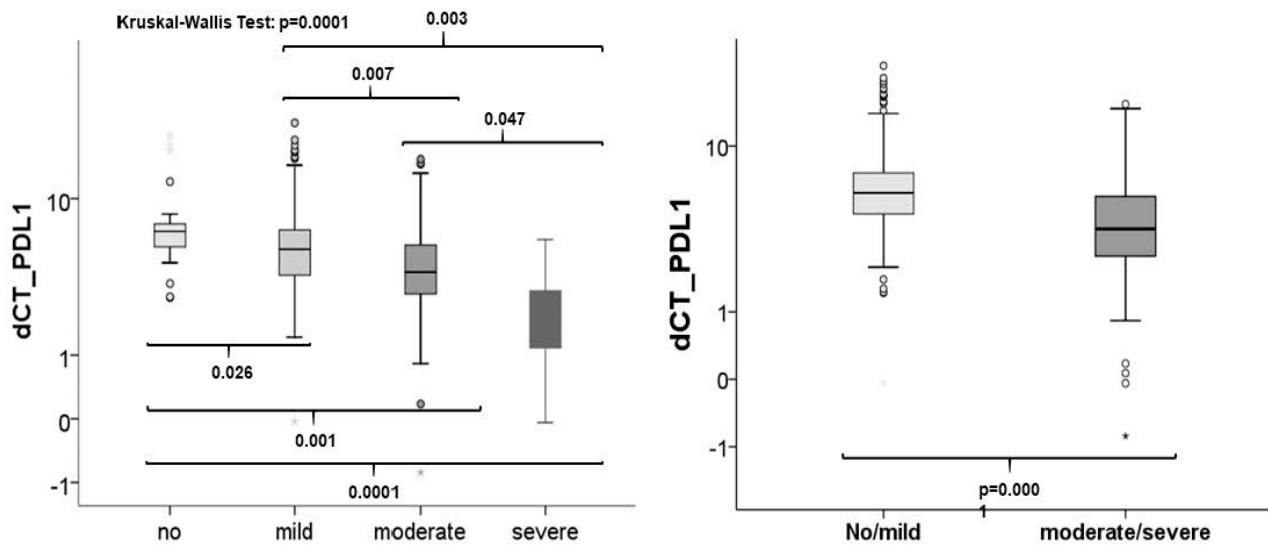
Figure 7. Association between inflammation and checkpoint expression. The comparison of the expression rates of all tissue sample groups to each other revealed that PD-L1 is statistically differentially expressed in tissues with diverse grades of inflammation (left). If OLP were grouped into low (no/mild) and high infiltration (moderate/severe) by inflammatory cells, a significant association between inflammation and expression could be seen (right).